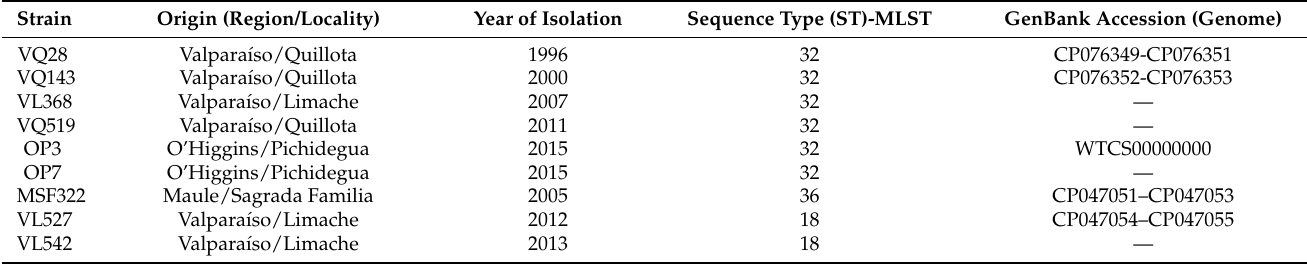
Table 1. Clavibacter michiganensis subsp. michiganensis strains used in this study and their respective Sequence-Type group determined by Multilocus Sequence Type analysis (ST-MLST)